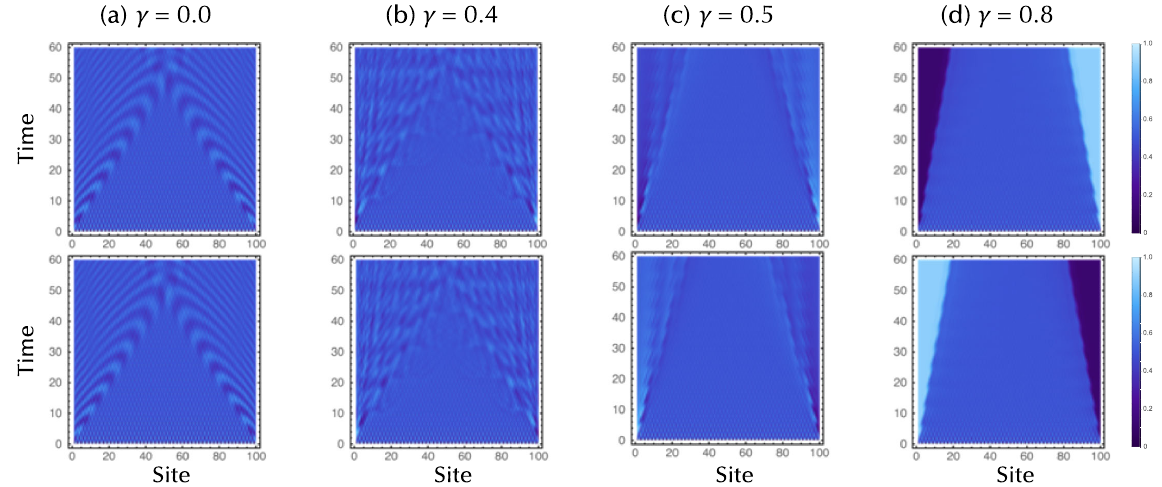
FIG. 8. Time evolution of the local particle number n l;s ð t Þ ≔ h ψ ð t Þj ˆ n l;s j ψ ð t Þi for s ¼ ↑ (top panels) and s ¼ ↓ (bottom panels) in the symplectic Hatano-Nelson model with open boundaries ( L ¼ 100 , J ¼ 1 . 0 , Δ ¼ 0 . 5 ). The initial state is prepared as Eq. (24). Non- Hermiticity is chosen to be (a) γ ¼ 0 . 0 , (b) γ ¼ 0 . 4 , (c) γ ¼ 0 . 5 , and (d) γ ¼ 0 . 8 . While no skin effect occurs for j γ j < j Δ j , the reciprocal skin effect occurs for j γ j > j Δ j